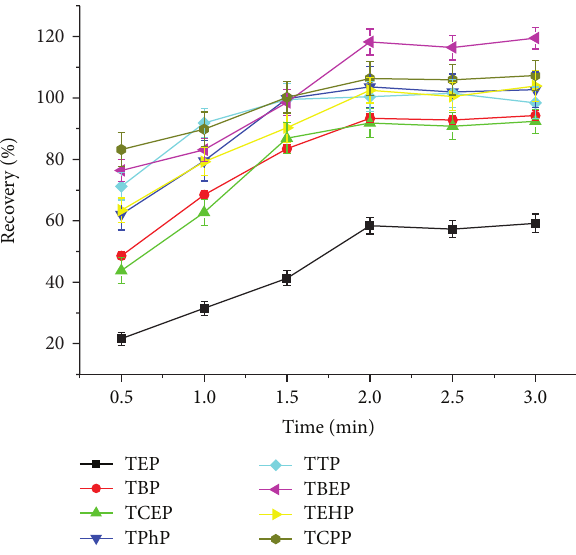
Figure 4: Optimization of vortexing time.